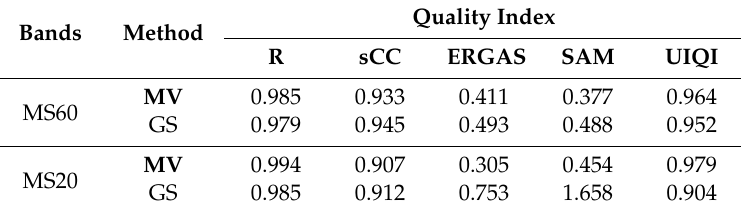
Table 2. Quality indices of fused Sentinel-2 bands generated by the two fusion algorithms for the Cuprite area.